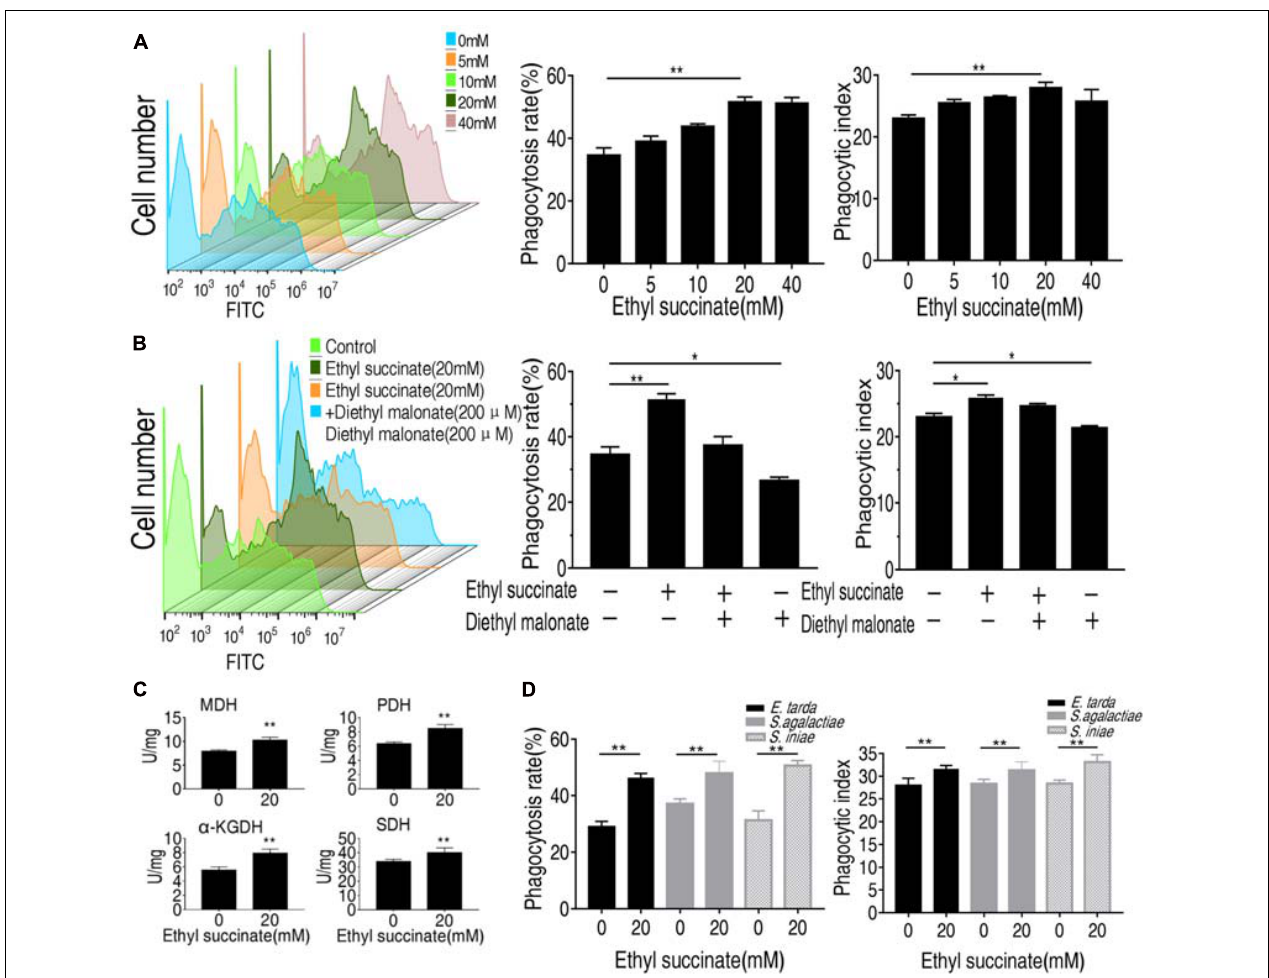
FIGURE 5 | Succinate promotes the phagocytosis of O. niloticus monocytes/macrophages. (A) the monocytes/macrophages were incubated with or without ethyl succinate (20 mM) for 4 h. (B) the monocytes/macrophages were incubated with or without succinate or diethyl malonate treatment for 4 h. (C) the monocytes/macrophages activity of PDH, MDH, KGDH, and SDH. (D) Phagocytosis rate and phagocytic index of FITC-conjugated gram-negative or gram-positive bacteria by succinate-pretreated monocytes/macrophages at indicated concentration. Error bars were represented as means ± SEM from three biological replicates. Statistical significance was obtained when * p < 0.05 or ** p <